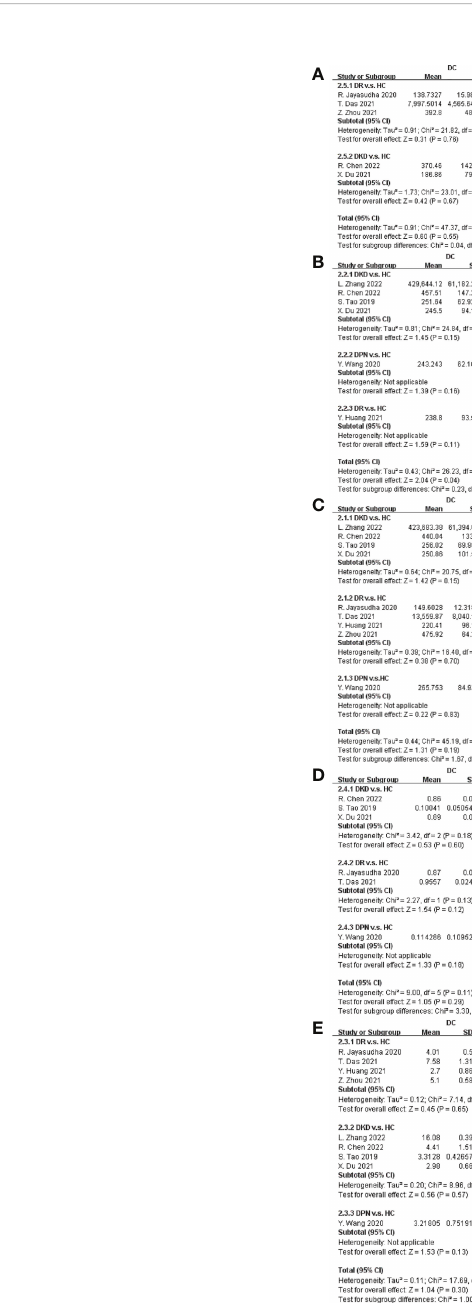
0.00001; SMD = -0.00, 95% CI[-0.00, -0.00], p < 0.00001; respectively), as well as an increase of Klebsiella (SMD = 0.00, 95% CI[0.00, 0.00], p < 0.00001). Besides, no consistent results